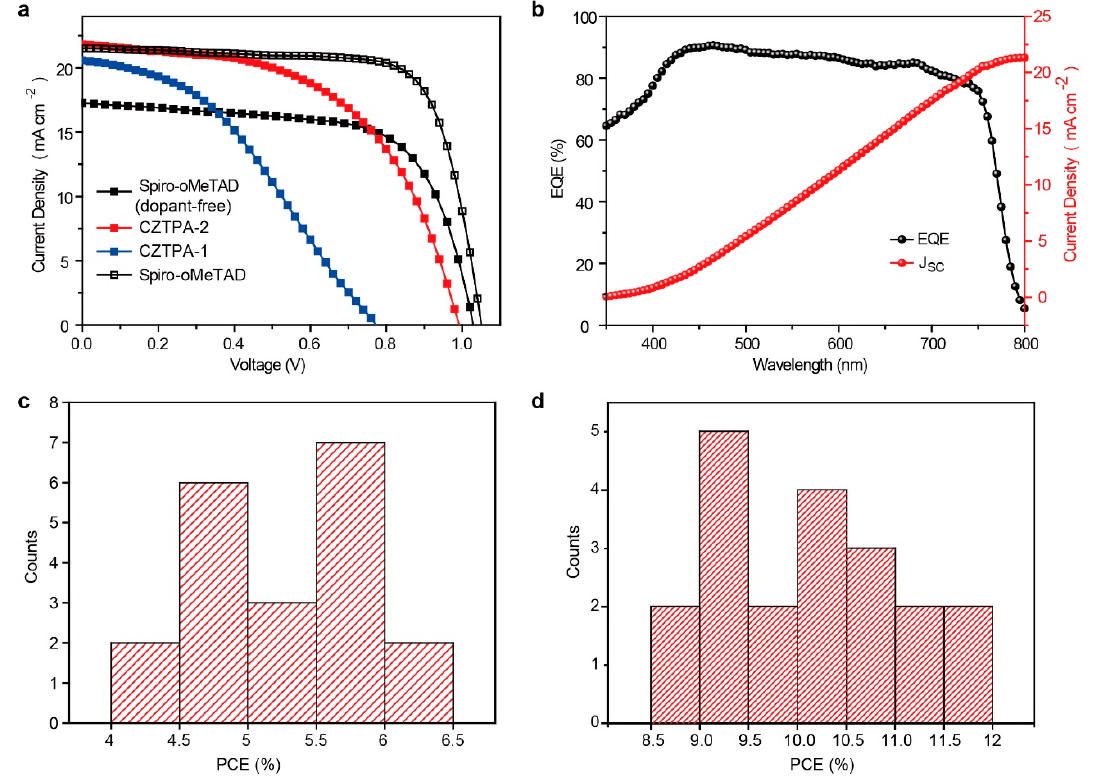
Figure 4. ( a ) J–V characteristics of PSCs based on the two hole transport materials (HTMs), the Spiro-OMeTAD, and the Spiro-OMeTAD (dopant-free). ( b ) External quantum efficiency (EQE) and J sc spectra of PSCs with CZTPA-2. ( c ) Histograms of PCEs measured in 20 cells of CZTPA-1. ( d ) Histograms of PCEs measured in 20 cells of CZTPA-2.